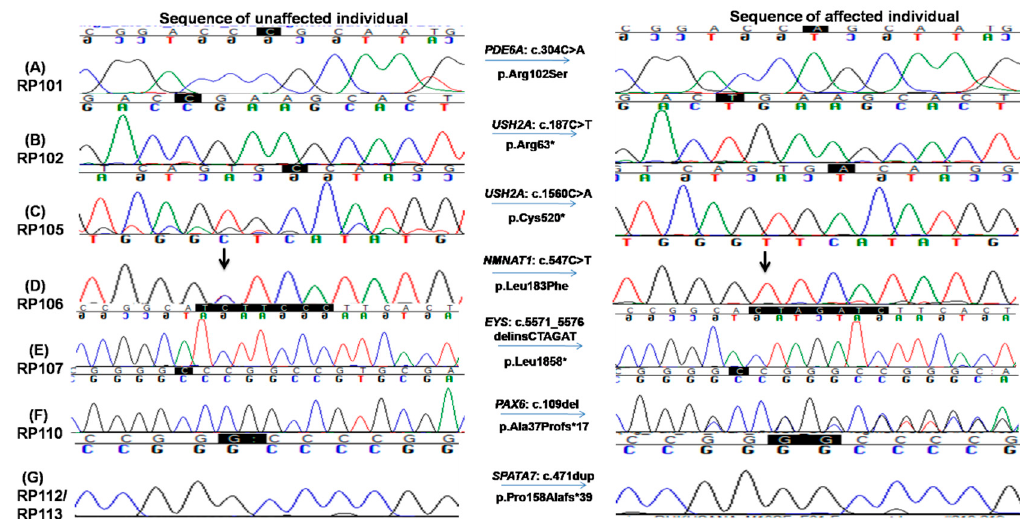
Figure 4. Chromatograms of known and novel disease causing variants (single nucleotide substitution/s, deletion, duplication and small INDELs) identified in this study, i.e., ( A ) c.304C>A in RP101, the homozygous sequence is shown on the left and homozygous mutated on the right (proband III.IV), ( B ) c.187C>T in RP102 showing homozygous normal on the left side and homozygous mutated on the right (proband IV.I) and ( C ) c.1560C>A in RP105 the homozygous wild-type sequence is shown on the left, whereas homozygous mutated on the right side (proband V.IV). ( D ) c.547C>T in RP106, homozygous mutated sequence is shown on the right, while homozygous normal sequence is present on the left (proband V.II); ( E ) c.5571_5576delinsCTAGAT in RP107 is shown on the right, whereas the sequence of normal individuals is shown on the left side; ( F ) c.109del in RP110 showing heterozygous mutated sequence on the right while wild-type sequence is shown on the left; and ( G ) c.471dup in RP112 and RP113, heterozygous mutated sequence is shown on the right, while normal sequence is on the left